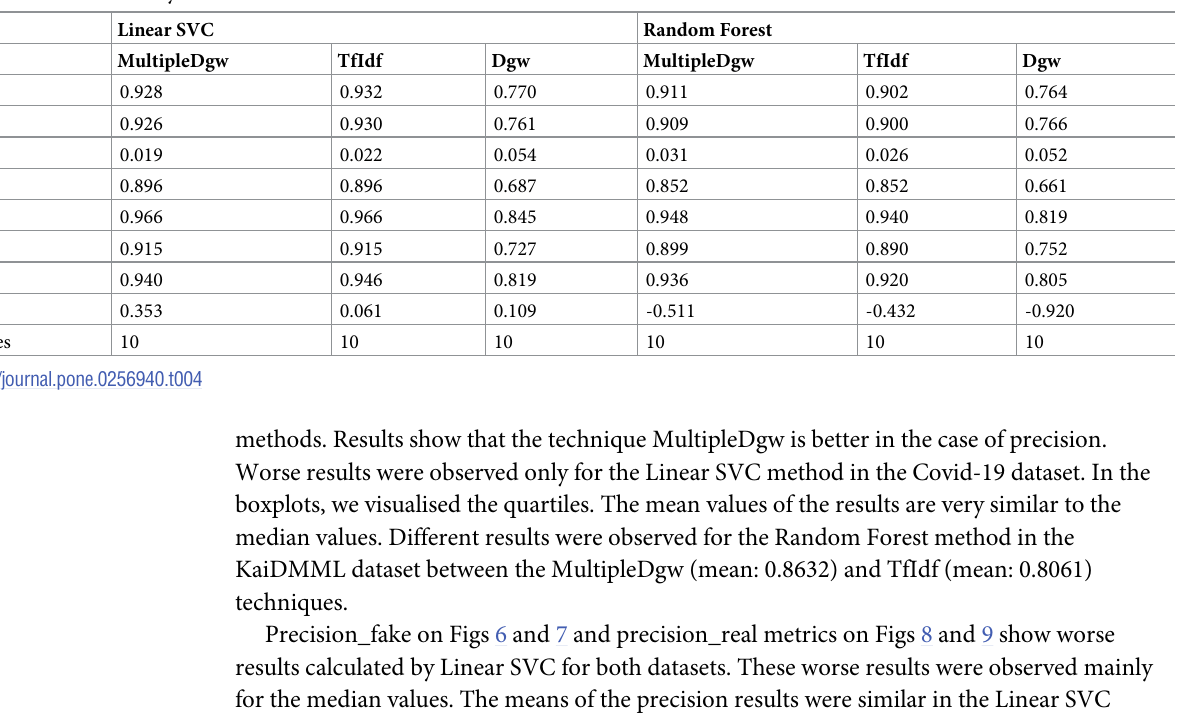
Table 4. Descriptive statistics for accuracy results for the Covid-19 dataset.